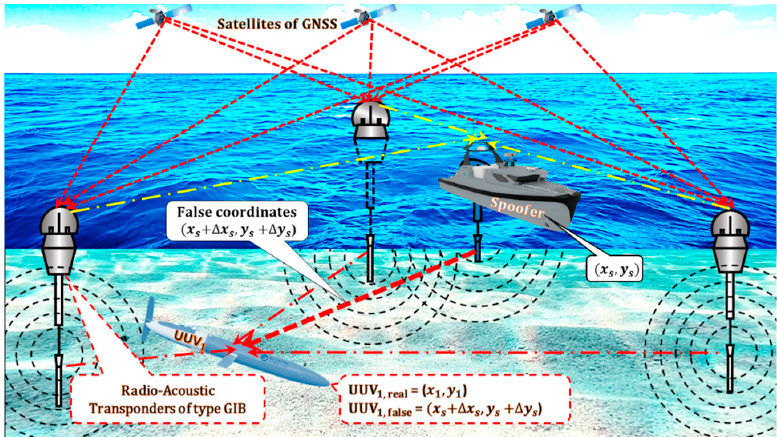
Figure 14. The basic LNSS self-spoofing scheme of UUVs: at some point in time, the self-spoofer determines its position ( x s , y s ) , introducing some delays into each of the satellite channels, intro- ducing some other signal distortion, and transmitting the false position ( x s + ∆ x s , y s + ∆ y s ) on the same frequency, which aims to deceive GIB receivers and create a false PVT solution. All UUVs in the self-spoofer activation zone are positioned as UUV i,false = ( x s + ∆ x s , y s + ∆ y s From a technical point of view, the LNSS self-spoofing of UUVs is the same spoofing, but here we have an absolutely different way of using spoofing, and if conventional anti-spoofing is based on the choice of technical means to protect oneself from spoofing, then anti-self-spoof- ing is based on the choice of technical means for attacking this self-spoofing in order to neu- tralize it, or at least to register the fact of its use by some vehicle including UUV. 13. The Brief Classification of Terrorist Attacks on USVs and UUVs Based on an in-depth analysis of the terrorist attack structures on USVs and UUVs presented here, we present a classification graph (Figure 15). Figure 15. The classification of terrorist attacks on USVs and UUVs.